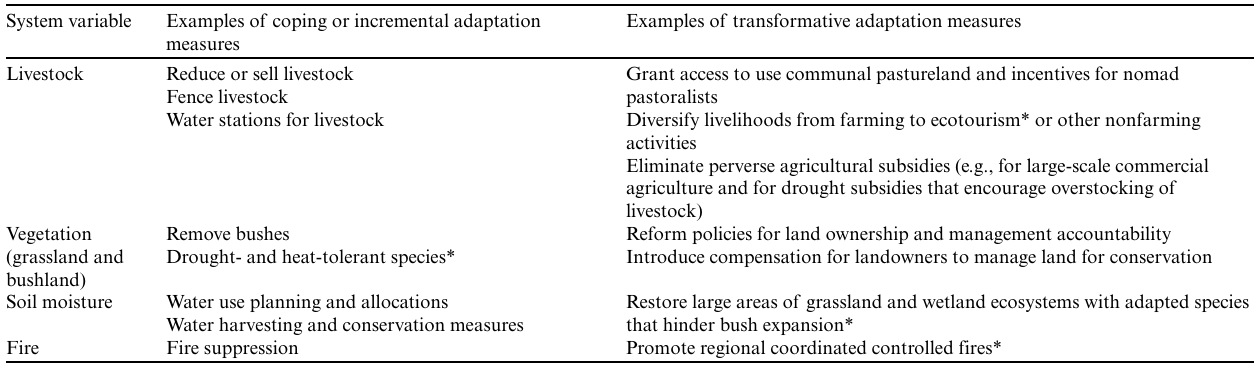
Table 3. Overview of implemented and planned adaptation strategies by cattle farmers in response to losses of grassland for pasture because of climate change (bush encroachment). Adaptation strategies are characterized by the type of adaptation measure (coping or incremental, or transformative) and whether they are ecosystem-based adaptation